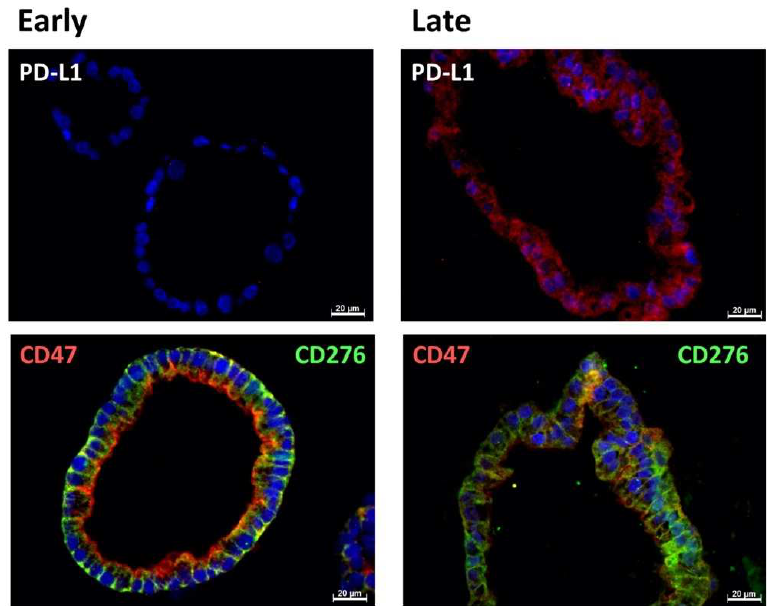
Figure 6. Expression of immune checkpoint antigens on BCO#147. Paraffin sections of organoids of BCO#147, a population with limited in vitro growth capacity, were generated and stained in early passage ( left panel ) or in later passage ( right panel ) with antibodies reactive with PD-L1, CD276, and CD47 as indicated. In the bottom panel, CD47 is visualized by red fluorescence, CD276 by green fluorescence. Size bars indicate 20 μm, respectively.